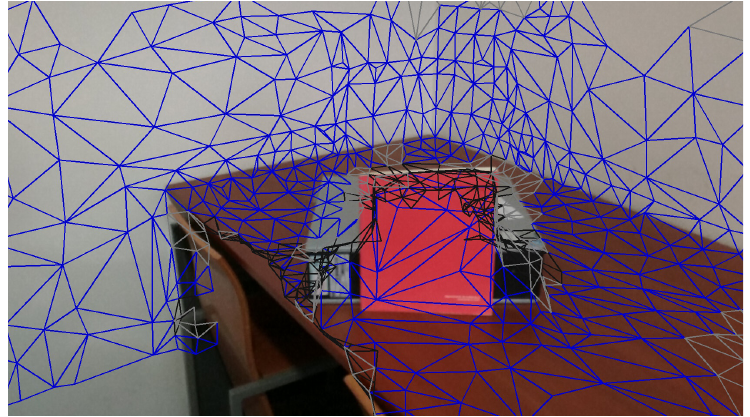
Figure 5. Face-based z-buffering. Black triangles are triangles detected as